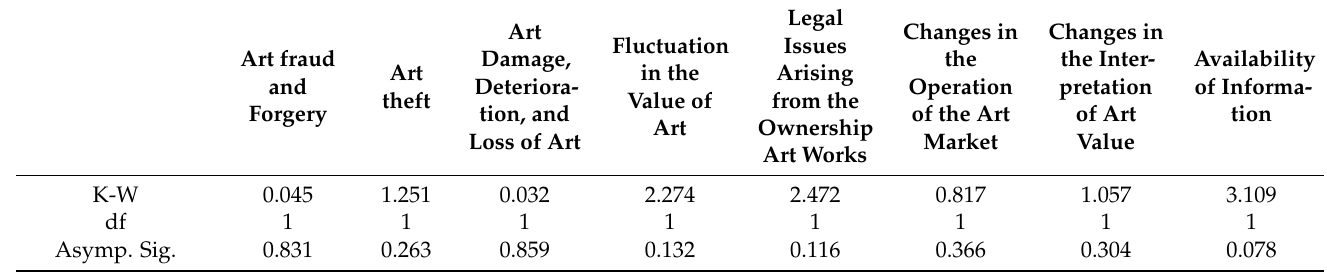
Table 19. Effects of position in the organization on art risk perception. Test statistics a,b .